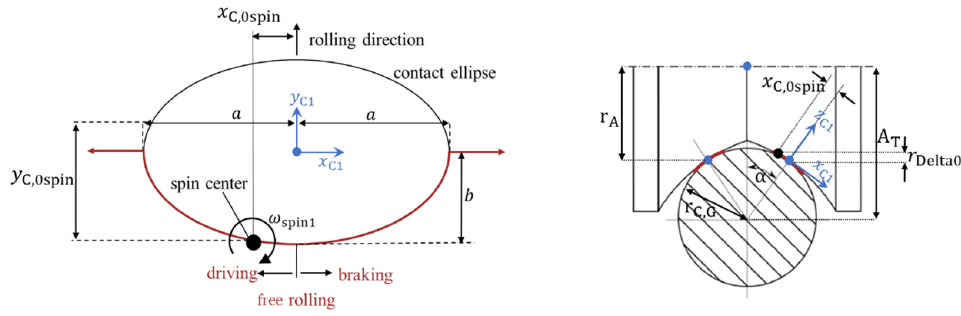
Figure 5. Movement of the spin center and characteristics of the contact surface in plain view ( left ), displacement of the spin center in the cross section ( right ).